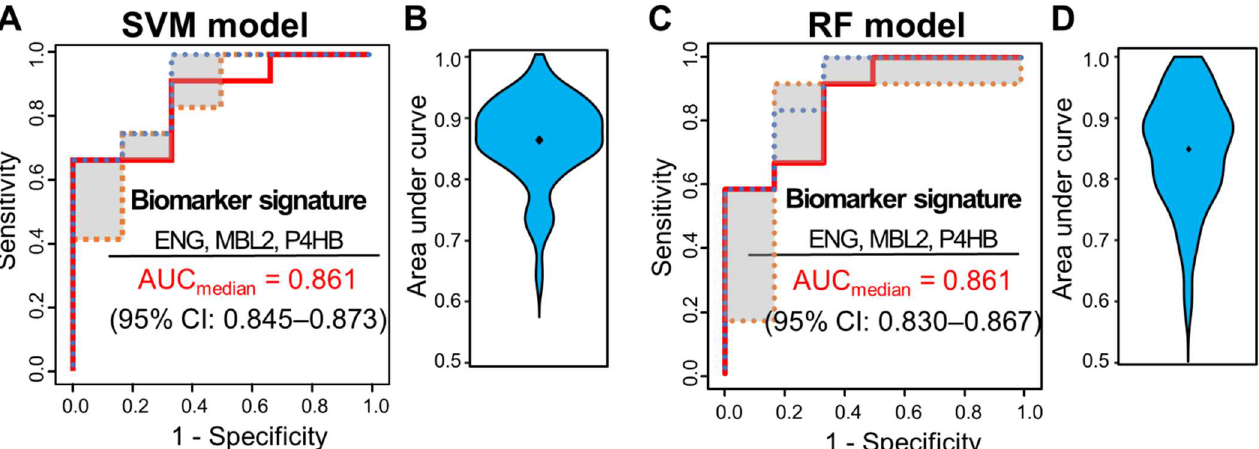
Figure 3. ROC curves of SVM and RF classifiers for three selected proteins (ENG, MBL2, and P4HB). Capability of the two classifiers in a set of 51 samples, 15 from patients with pCR and 36 from patients with non-pCR. ( A ) ROC curves of SVM classifiers generated through 100 repeats of threefold cross-validation steps. ROC curves were obtained by plotting the 25th, 50th, and 75th quantiles of the sensitivities for each value of 1-specificity. ( B ) Violin plots of 100 area under the curve (AUC) values in the SVM model. ( C ) ROC curves of RF classifiers generated through 100 repeats of threefold cross-validation steps. ROC curves were obtained by plotting the 25th, 50th, and 75th quantiles of the sensitivities for each value of 1-specificity. ( D ) Violin plots of 100 AUC values in the RF